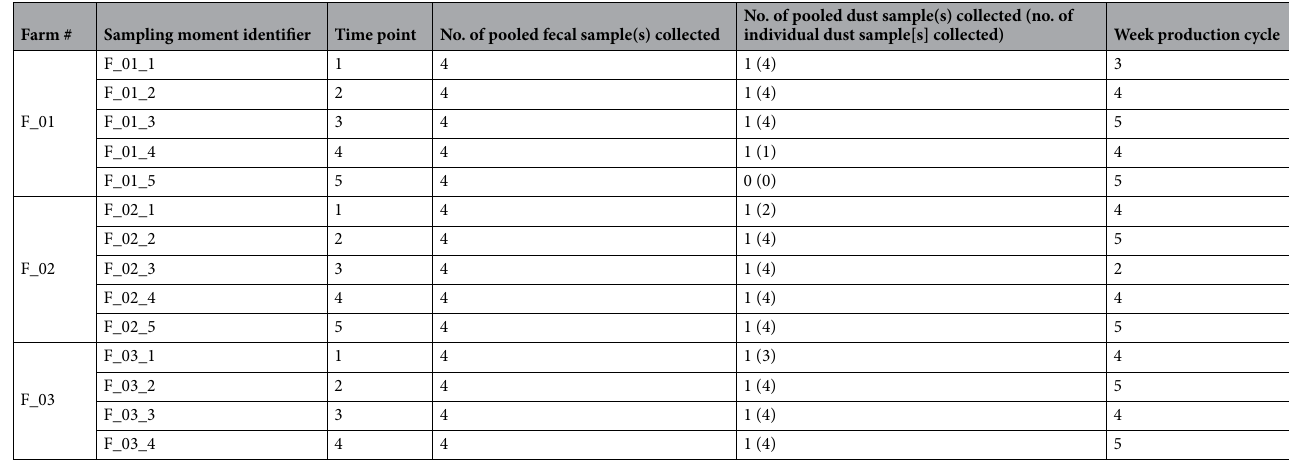
Phylogenetic analysis. Sequences with ≥ 80% of genome coverage from the Picornaviridae , Astroviri-